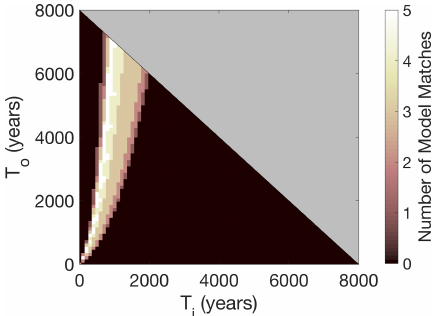
Figure 6. Stacked results from ionic diffusion modeling of all six chemical parameters. T o represents the length of time over which the topmost sediment was exposed to ocean water after initial grounding line retreat and before grounding line readvance. T i rep- resents the length of time over which the topmost sediment was exposed to subglacial conditions between the grounding line read- vance over SLW and now. The number of model runs included in this figure is